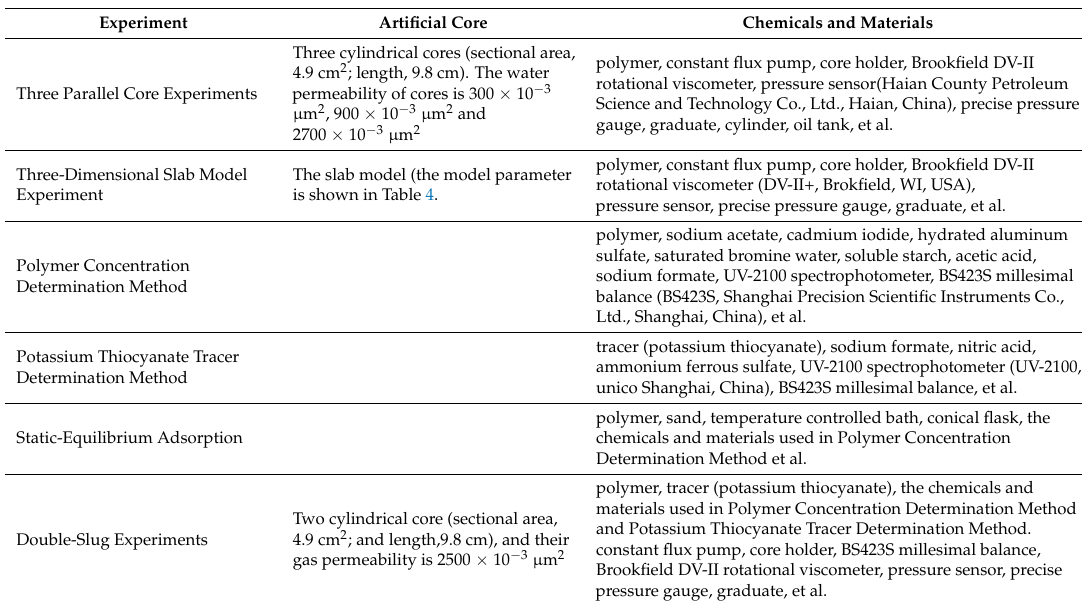
Table 3. List of materials required for